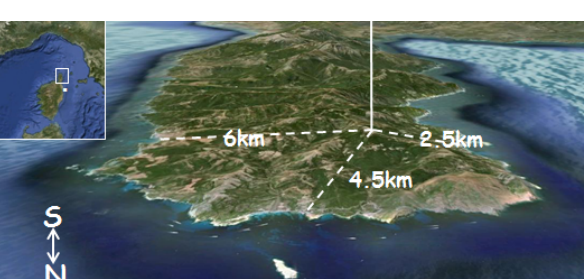
Figure 1. Localization and geographical configuration of the mea- surement site in Ersa at Cape Corse (source: Google Maps). The white solid square in the insert (top left) represents the localization of the city of